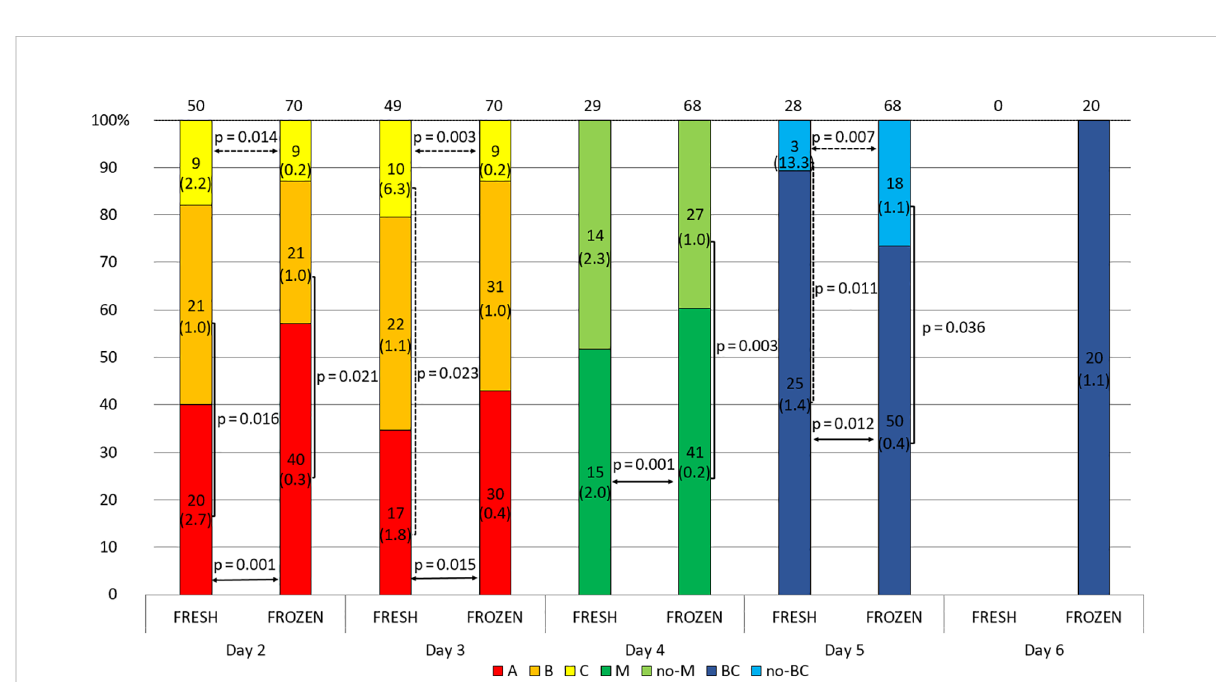
FIGURE 5 Effect of embryo quality on the concentration of secreted HLA-G in the fresh and frozen cycle. 1) development of embryos over time from the second to the sixth day (height of the colored stripes); 2) secretion comparisons between fresh and frozen cycle groups (horizontal arrows); 3) comparisons of secretion between embryos of different classes or stages of development (vertical clamps). A, B, C – class of the embryo, M – embryo in the morula stage; no-M – embryo that has not reached the morula stage; BC – embryo in the blastocyst stage; no-BC – embryo that has not reached the blastocyst stage; Dashed line – p-value resulting from analyses with insuf fi cient number of embryos. Median concentration of sHLA-G was presented in brackets. P-values are calculated by Mann-Whitney test or t-test.